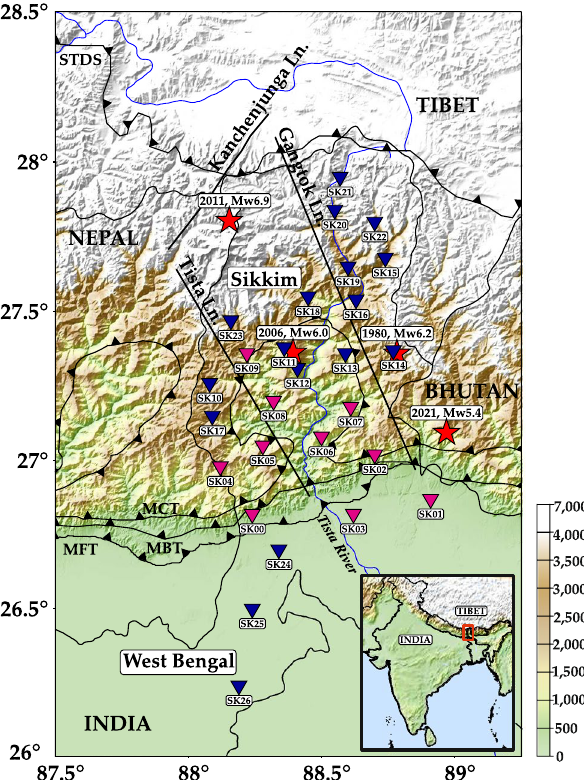
Figure 1. Station map of the seismic network installed in Sikkim Himalaya and regions of the Himalayan foreland basin in the northern West Bengal. Stations with the sensor installed on pier are represented with pink inverted triangles and stations with the sensor buried are represented in blue inverted triangles. Red stars represent the epicenters of major earthquakes that occurred in and around Sikkim (Source: ISC earthquake catalogue 37–39 ). South Tibet Detachment System (STDS), Main Frontal Thrust (MFT), Main Boundary Thrust (MBT), Main Central Thrust (MCT), major fault lines and lineaments are also shown. Inset: Map of India highlighted with the study area. Software used to generate the figure: Generic Mapping Tools (GMT) v6.0.0 40